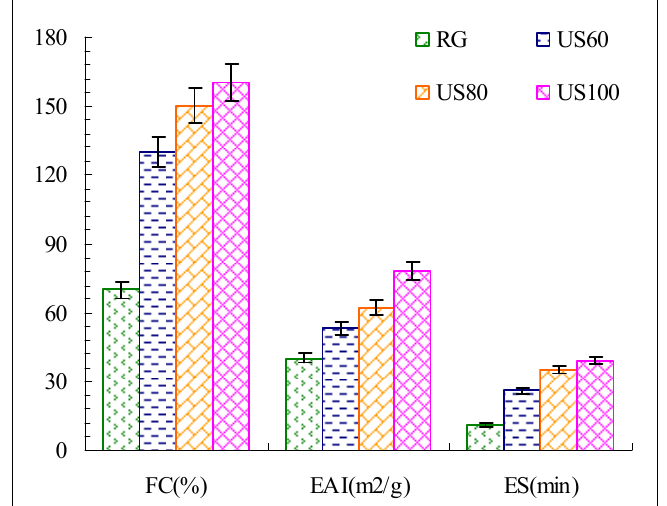
Figure 2. Foam capacity, Emulsifying properties, and Emulsion stability of ultrasound treated gluten protein samples.